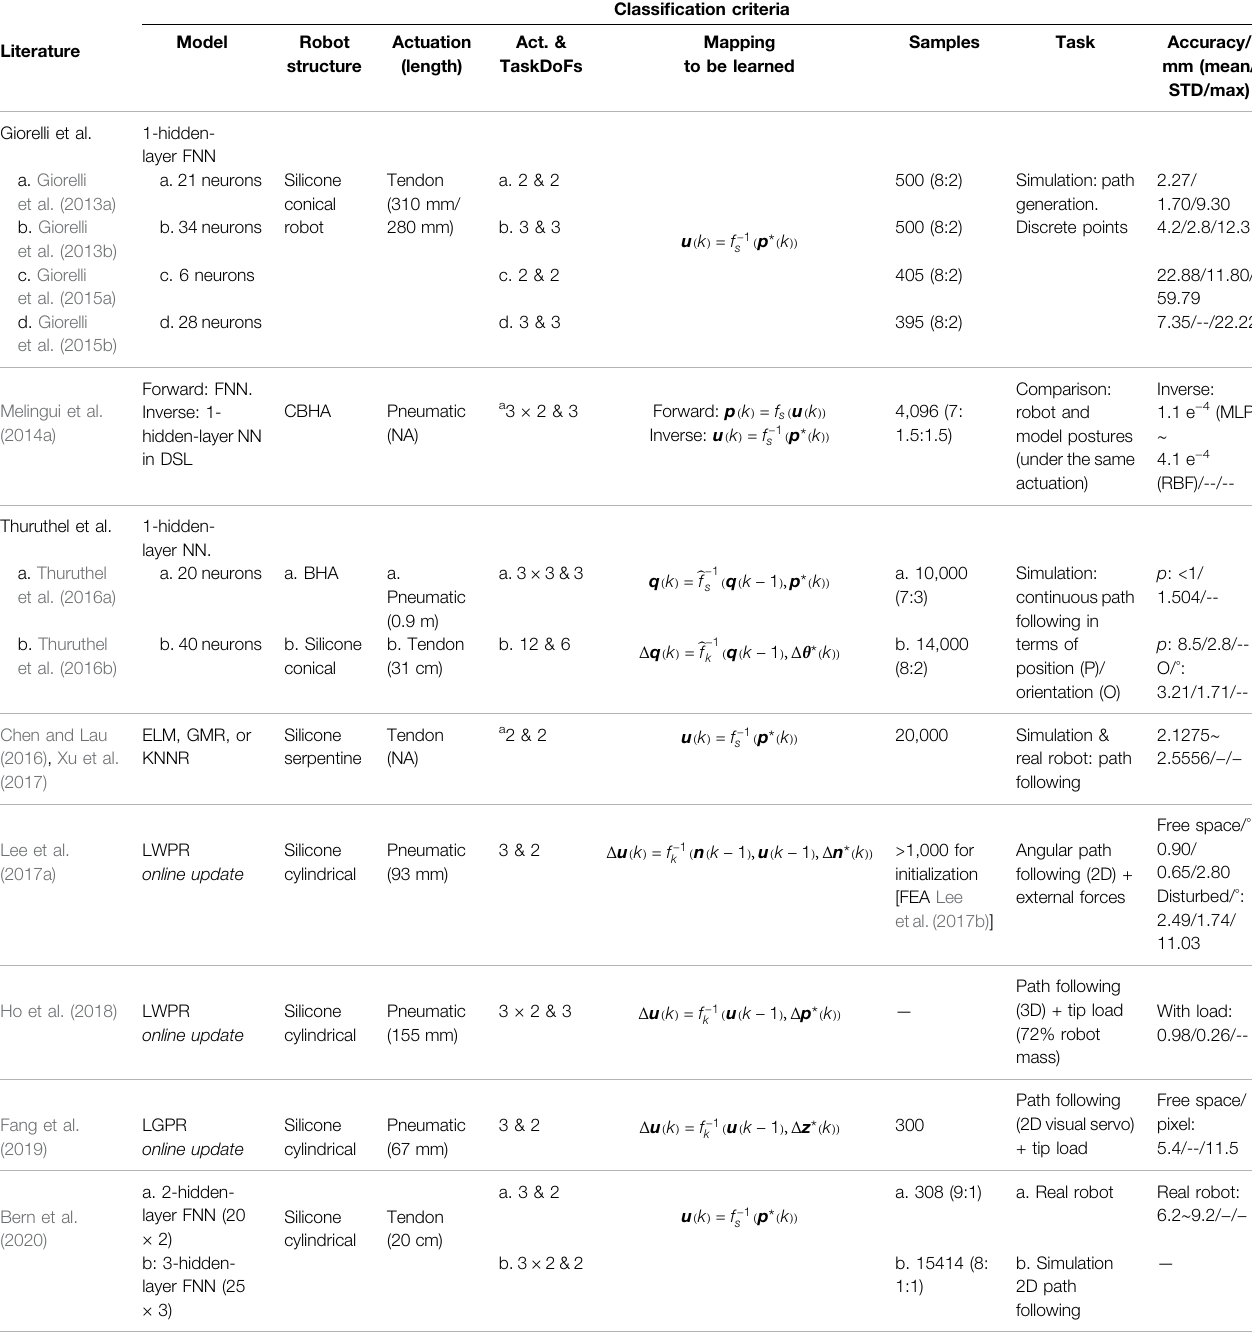
TABLE 1 | Sampling of inverse statics/kinematics learning-based control for continuum robots. Intended to be exemplary, not comprehensive.